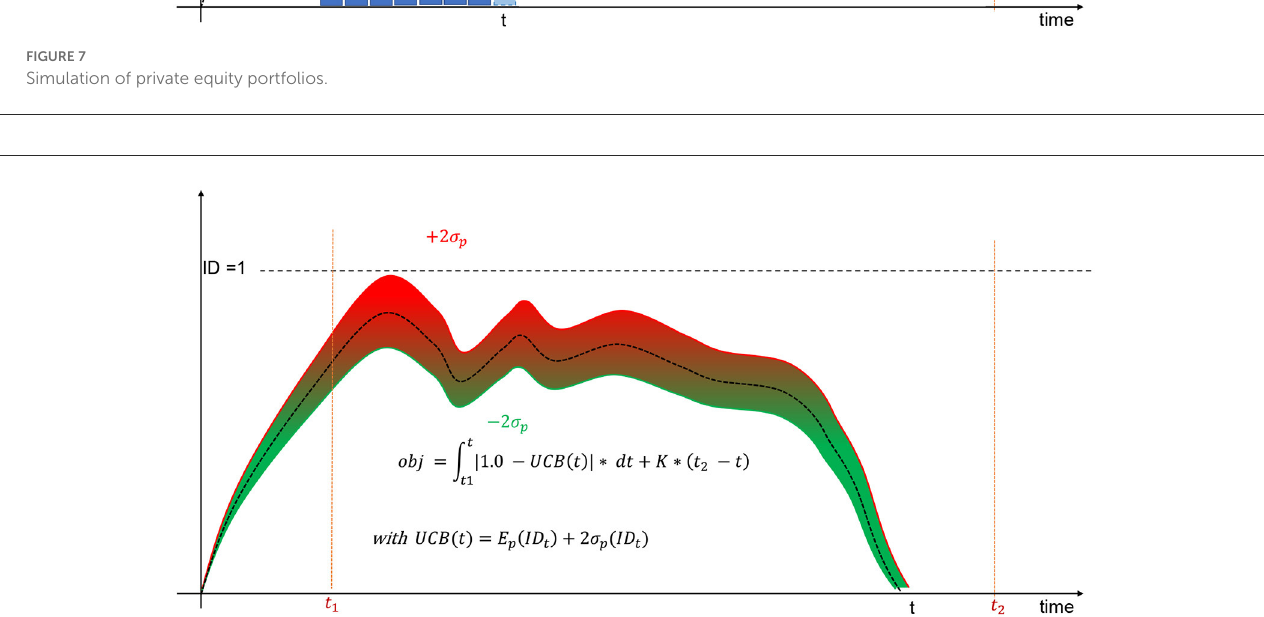
FIGURE8 Upper-confidence bound